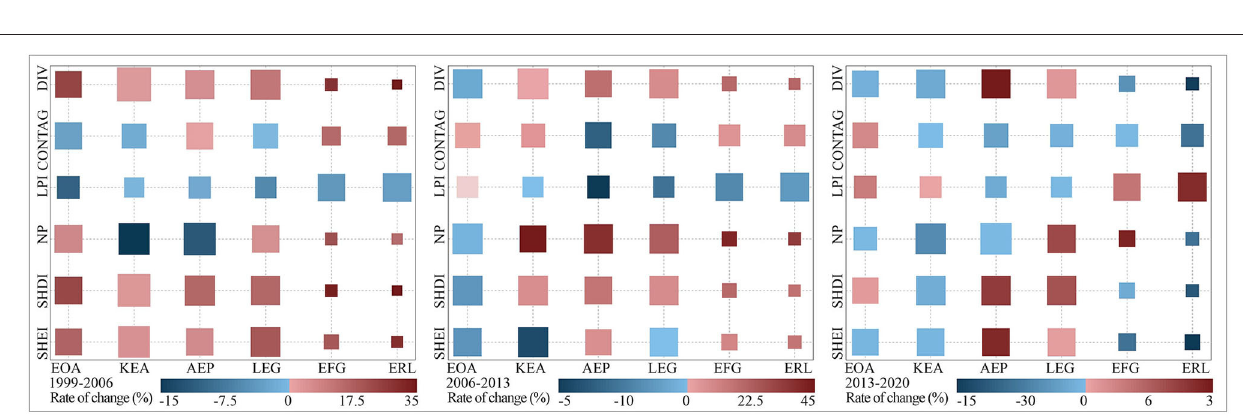
including the CONTAG index, which was different